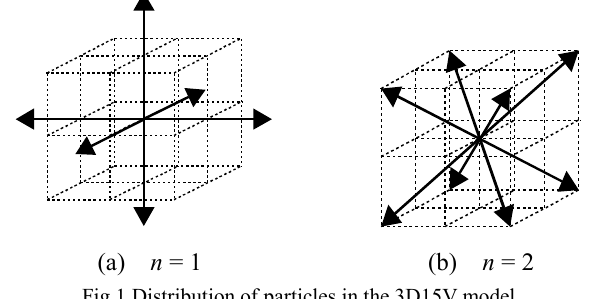
Fig.1 Distribution of particles in the 3D15V